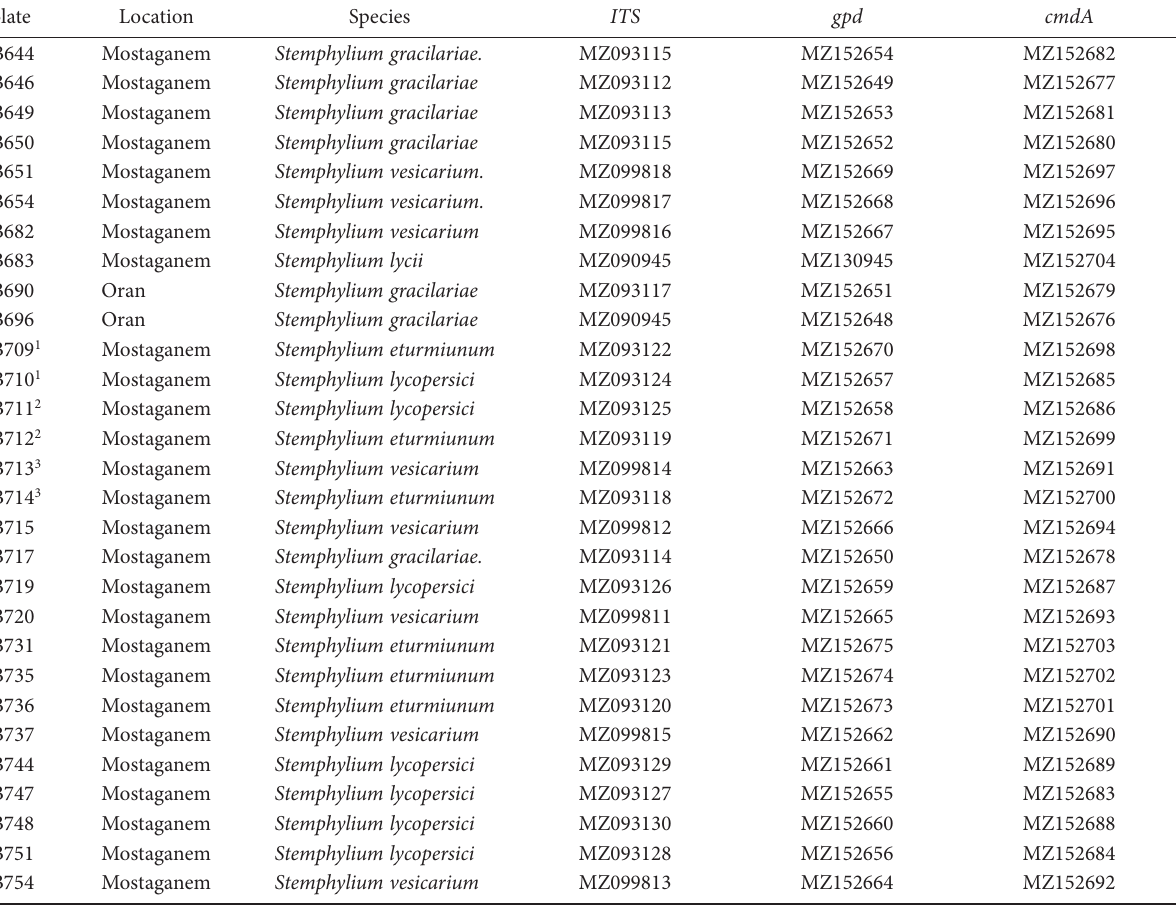
Table 1. Stemphylium isolates from tomato characterized in this study, their geographical origins, and the GenBank accession numbers of their internal transcribed spacer ( ITS ), glyceraldehyde-3-phosphate dehydrogenase ( gpd ) and calmodulin marker ( cmdA ) genomic sequences. Isolate